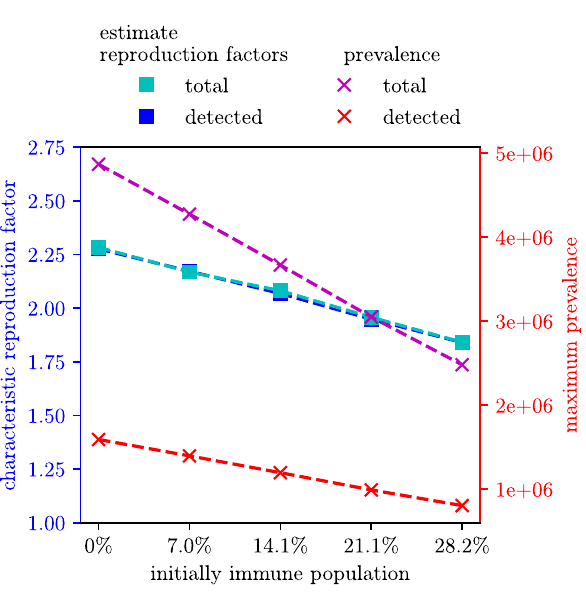
R eff and maximal prevalence as a function of initial immunization (cid:31)